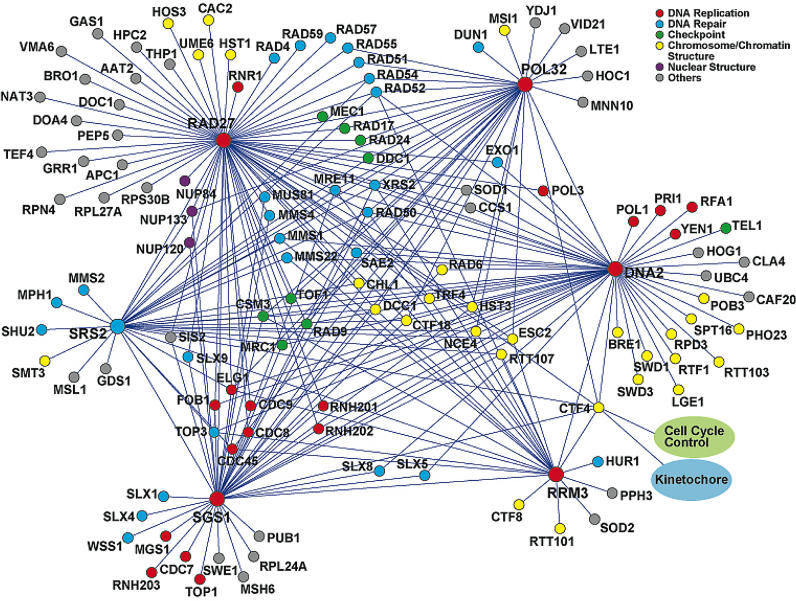
A Genome Stability NetworkData were compiled with the Payek program using the dna2 screen results in Table 1 and the results of the previous screens [18,19,92], as well as data compiled for candidate genes synthetically lethal with rrm3Δ [47,75]. The data are presented in tabular form in Table S2.